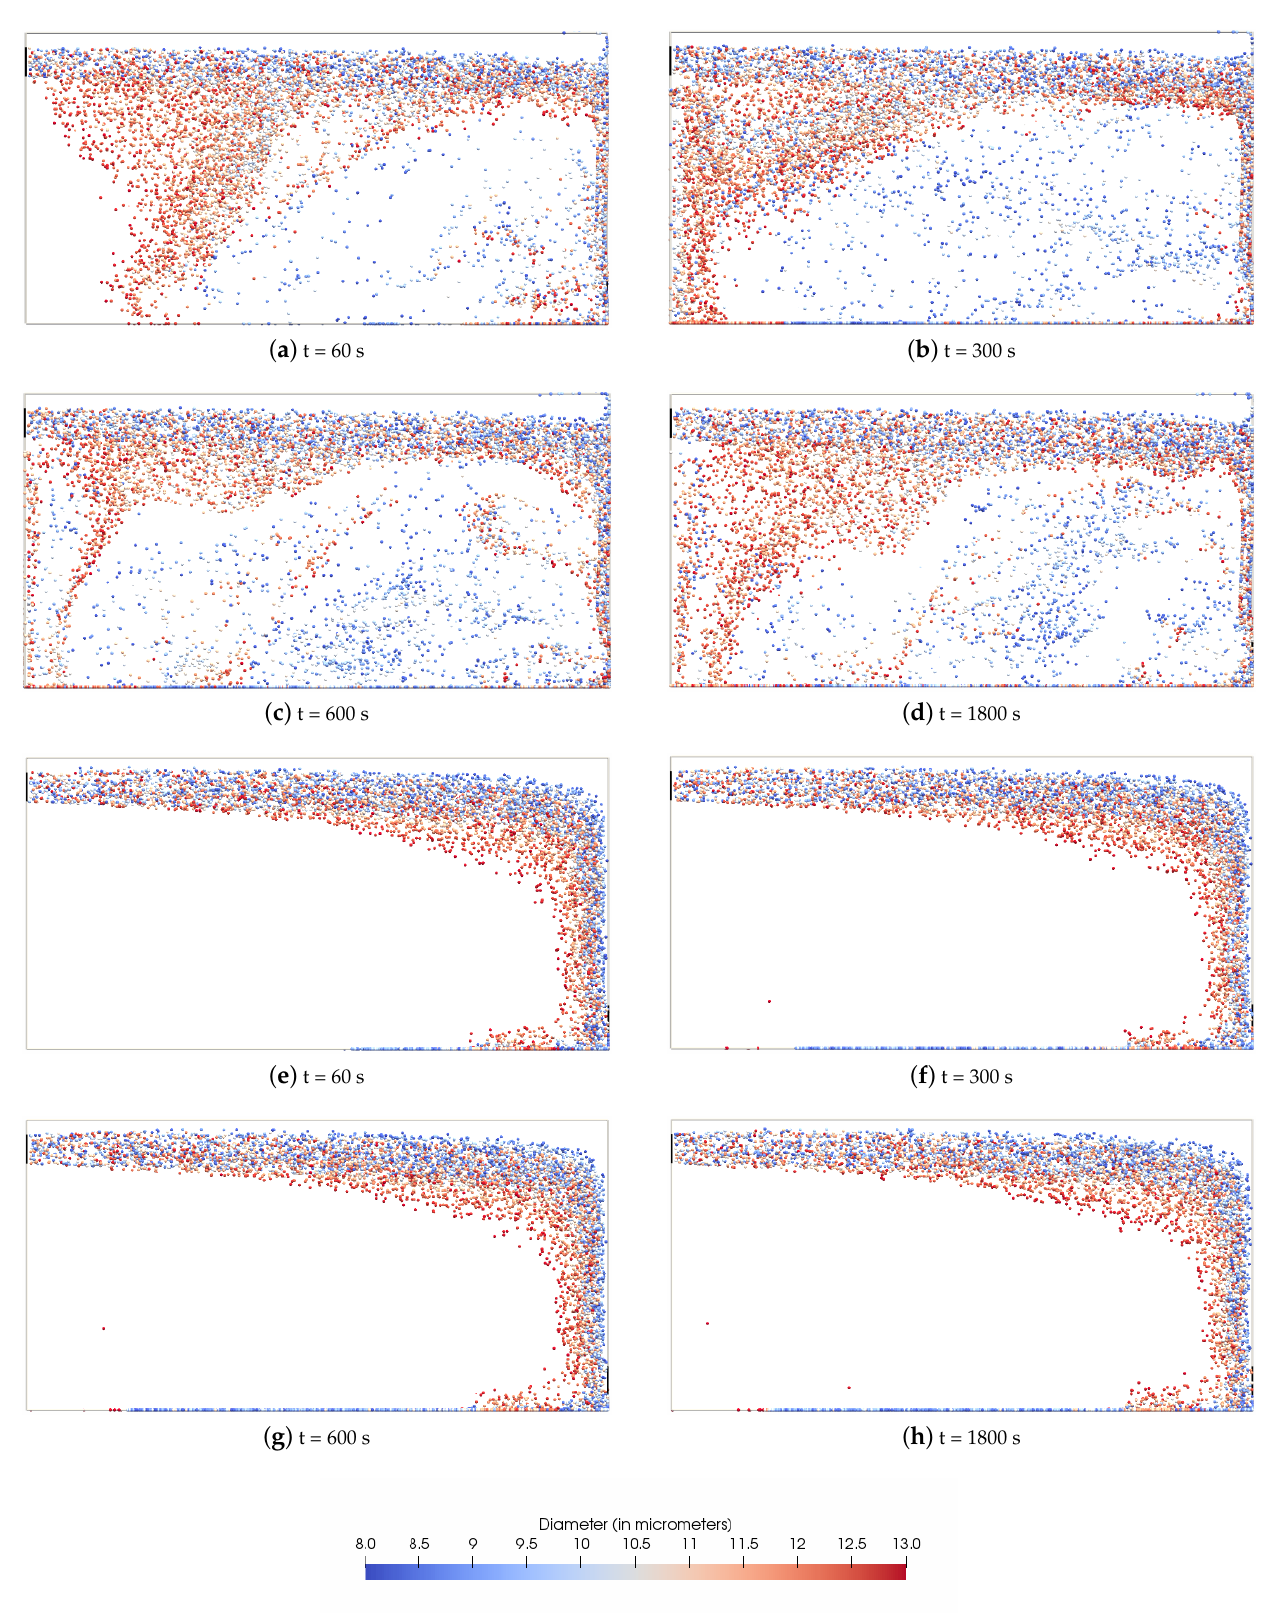
Figure 7. Particle phase at different times (LES—( a – d ) and URANS ( e – h